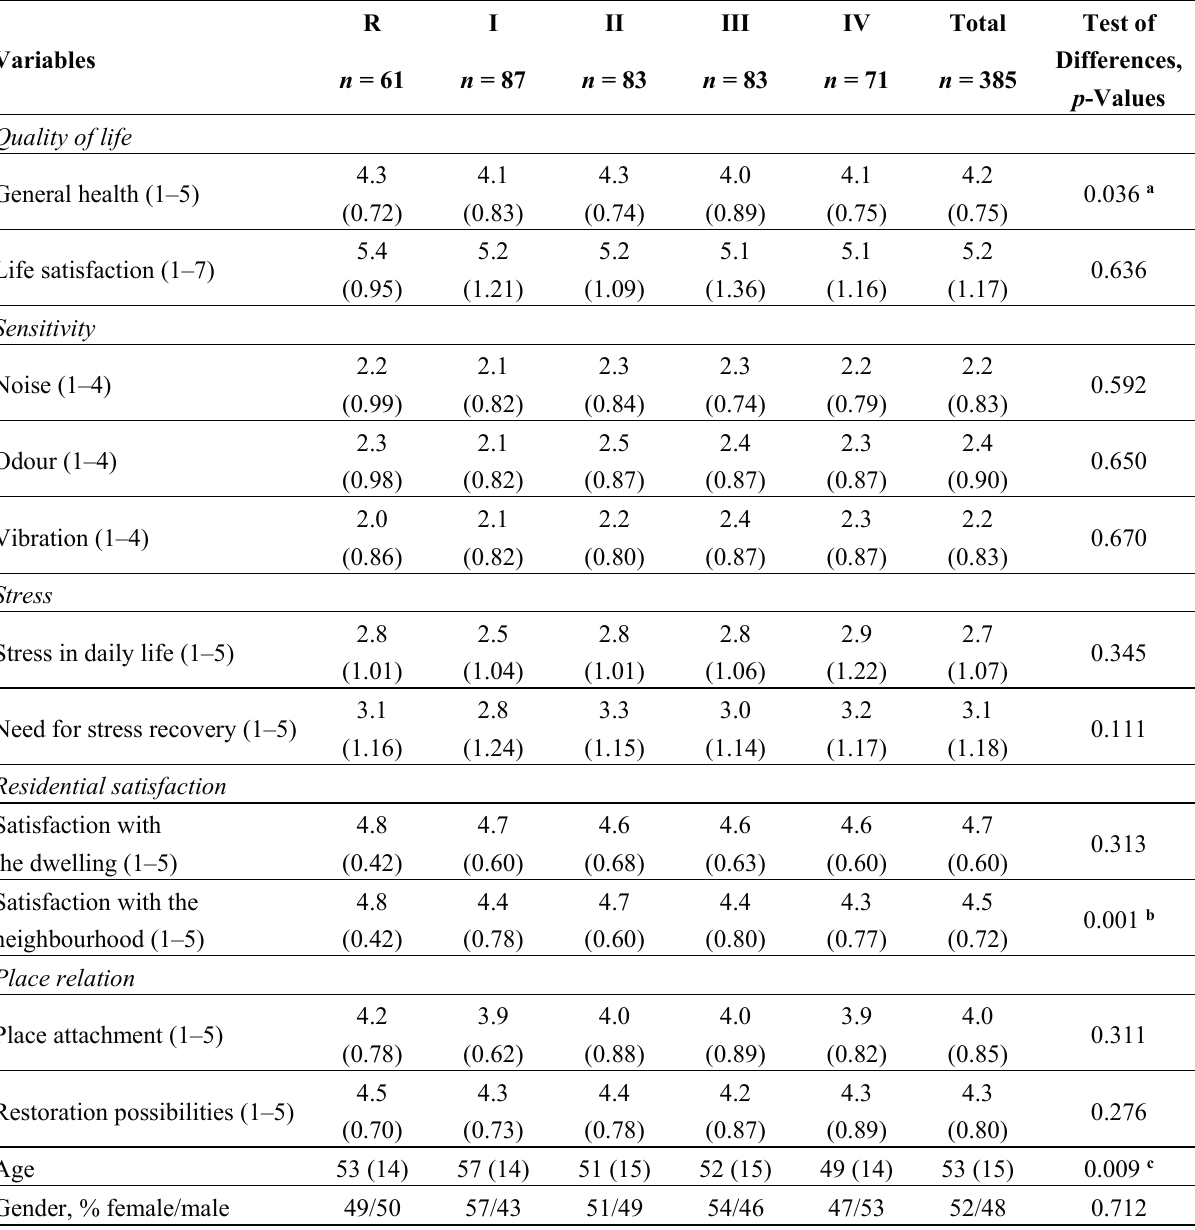
Table 4. Variables measuring quality of life, sensitivity, stress, residential satisfaction, and place relation: mean values (with standard deviations in parentheses) for each area and in